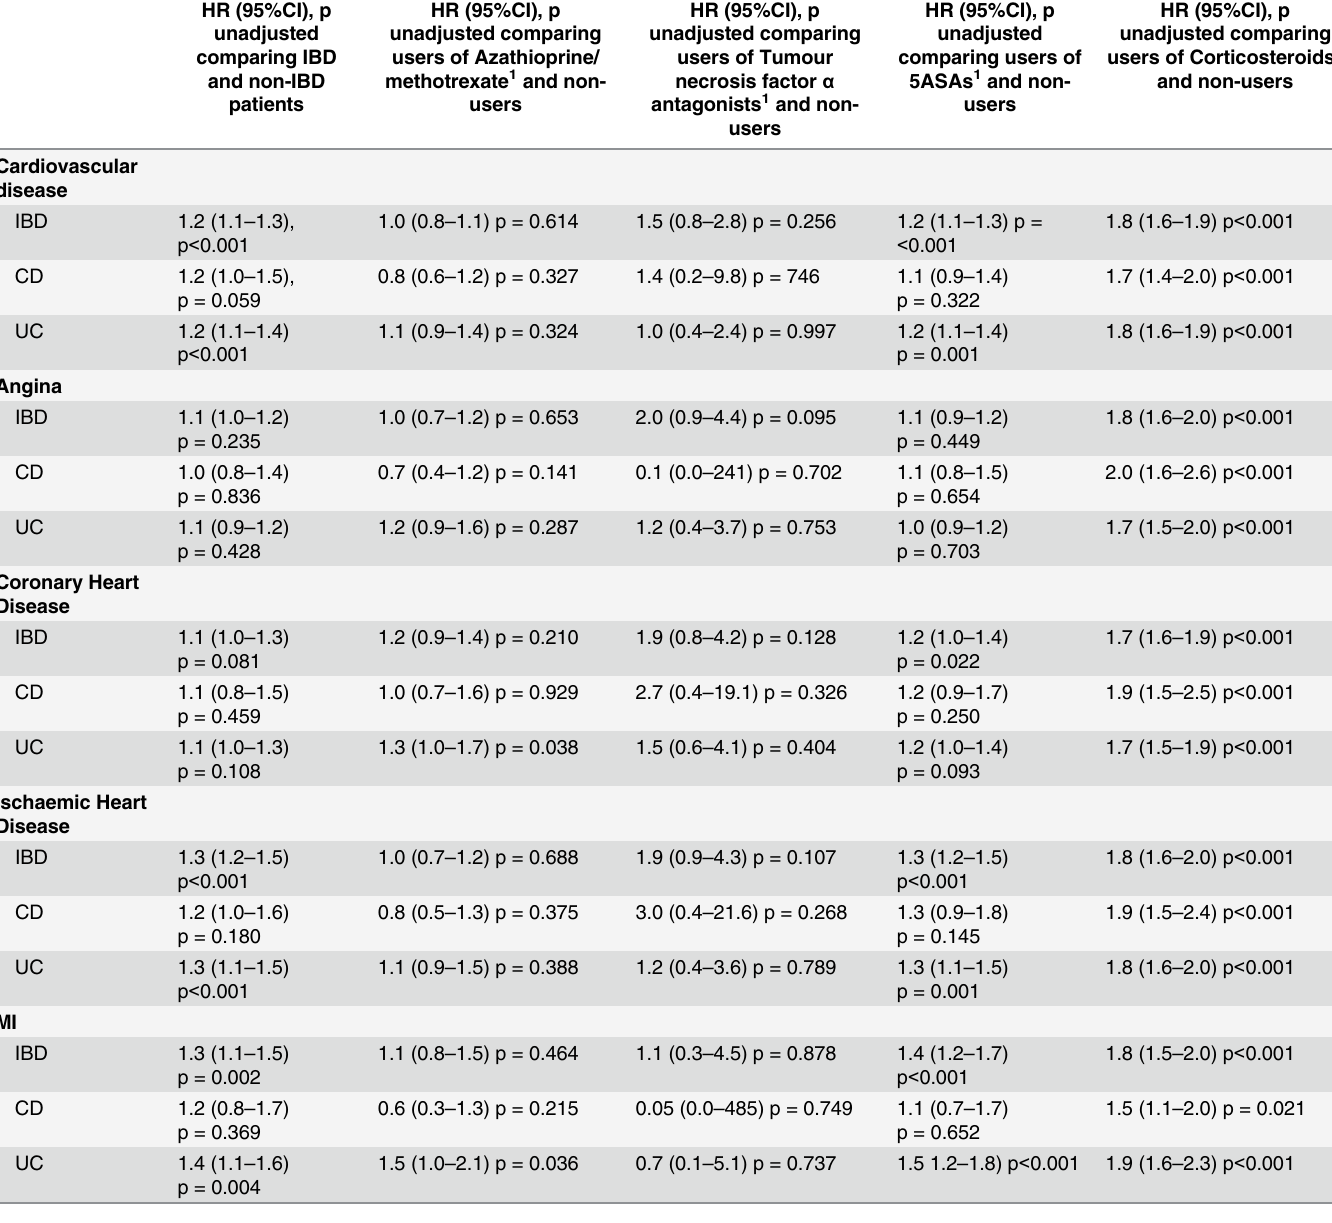
Table 5. Unadjusted hazard ratios for cardiovascular disease comparing IBD drug users * and non-users (COHORT B). HR (95%CI), p